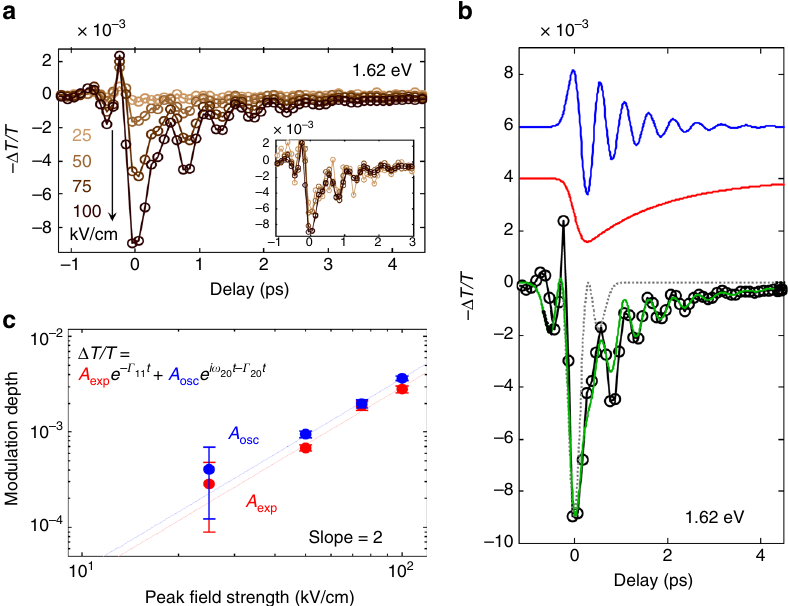
Fig. 2 Nonlinear optical response to the THz fi eld. a Optical transmission changes ( − Δ T/T ) at probe energy of 1.62 eV induced by THz excitation pulses (cid:1) Δ T E x ; peak ð having peak fi eld strengths of 25, 50, 75, and 100 kV/cm. Inset : Each time trace of the optical response is scaled by peak fi eld strength (100 kV/cm) of the strongest THz pulse and E x ,peak is the peak fi eld strength of a given THz pulse. The overlap of scaled time traces shows the overall quadratic dependence of the transient differential spectra at t > 1 ps on the incident THz fi eld strength. b Contributions to the optical response ( − Δ T/T )) as determined from the phenomenological model (damped oscillator, see SI). Blue and red traces show the decomposed oscillation and exponential components obtained from fi tting the model (equation given in c ) at t > 1.3 ps to the data at a probe energy of 1.62 eV (for error estimation, see SI). To extrapolate these contributions to times t < 1.3 ps we convolve the modeled response with a Gaussian function (FWHM: 350 fs from the THz pulse width). These contributions together with the instantaneous electro-absorption ( dotted gray line ) agree well with the experimental data ( cf . modeled green line and experimental black line ). c Fitted amplitudes of both oscillatory ( A osc ) and exponential ( A exp ) components (according to the shown equation) scale quadratically on the incident THz peak fi eld strength, reinforcing the second order (nonlinear) nature of the optical response with respect to the THz